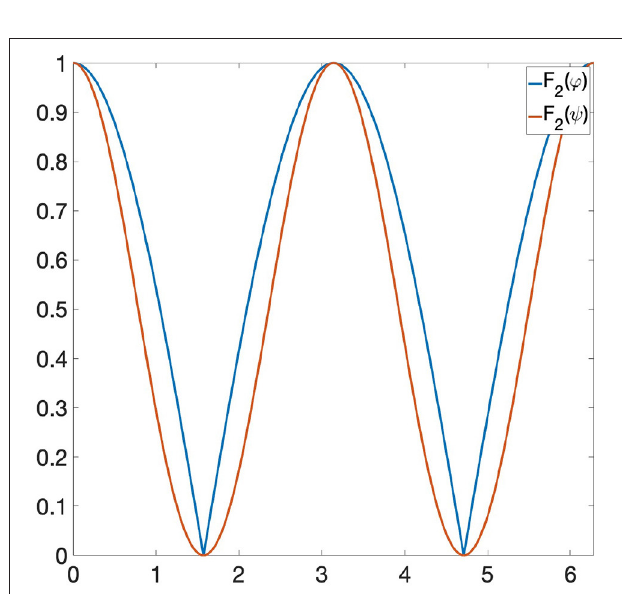
FIGURE 3 | F 2 ( ϕ ) and F 2 ( ψ ) have the same persistence diagram.